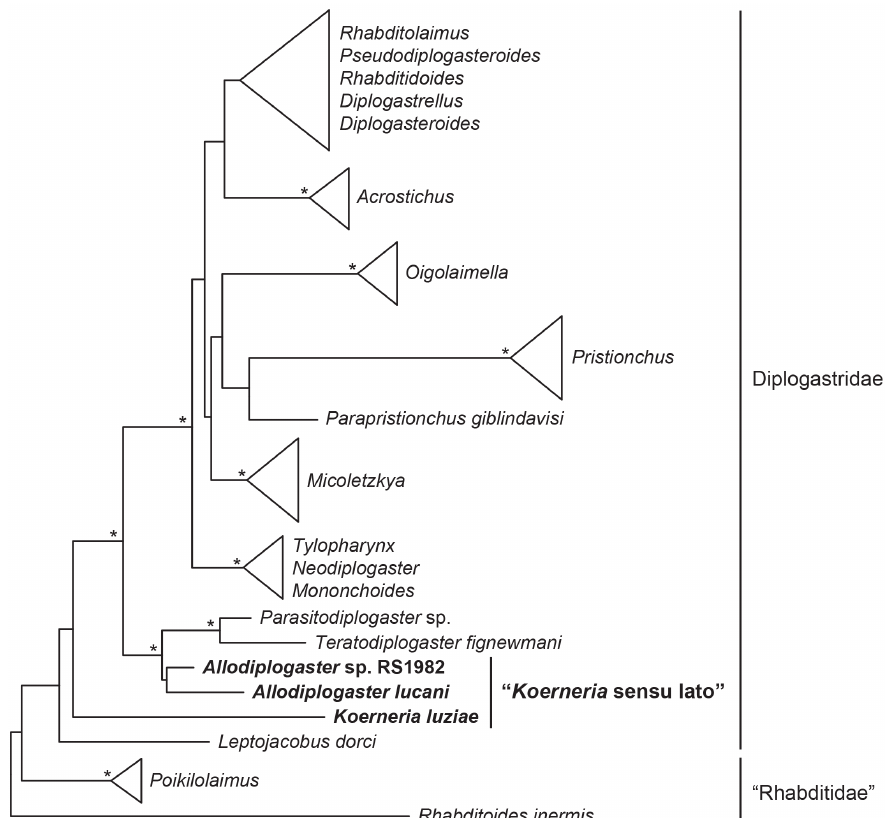
Figure 1. Paraphyly of Koerneria sensu lato. Tree is simplified from Kanzaki et al. (2014b), which was in- ferred from nearly full-length small subunit ribosomal DNA sequences. A subsequent study that included several more species of Koerneria sensu lato likewise showed the well-supported exclusion (99% bootstrap support in likelihood analysis, 100% posterior probability in Bayesian analysis) of a clade of K. luziae + K. ruehmi from all other Diplogastridae, including a monophyletic clade of what is designated herein as Allodiplogaster (Atighi et al. 2013). Asterisks indicate nodes with very strong support as inferred in the former study (>95% bootstrap support, 100% posterior